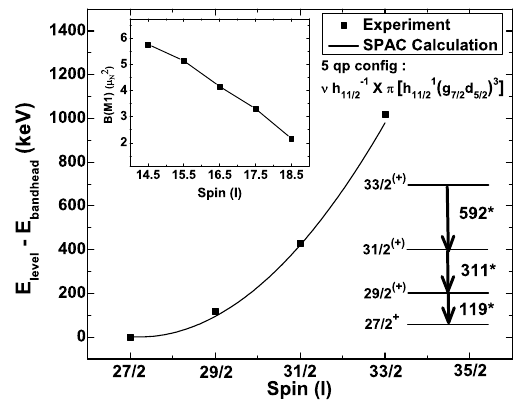
Figure 5. Level energy (E le v el ) with respect to the band head energy (E bandhead ) as a function of level spin which is compared with the SPAC calculation. The level sequence with the decaying γ rays are also shown. The inset shows the calculated B(M1) values using SPAC model as function of level